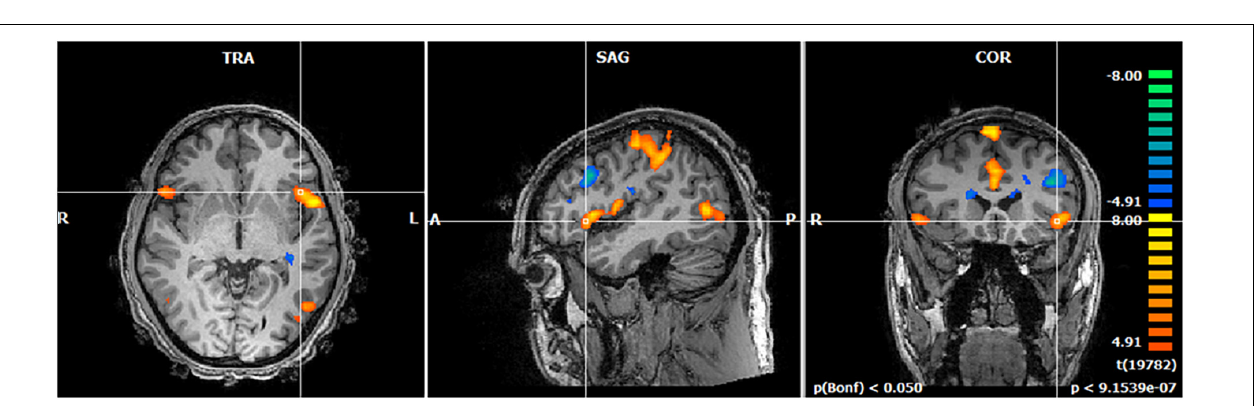
FIGURE 2 | Summary of behavioral data. Subjects’ accuracy reported as precision and sensitivity measures are reported in the left plot. Notably, subjects 5 and 6, as well as subject 11, did not report any bugs; thus, we were not able to calculate their parameters. The box plot on the right has shown the average delays from code start to the eureka moments. No significant differences were found between events. TP, true positive; FP, false positive.